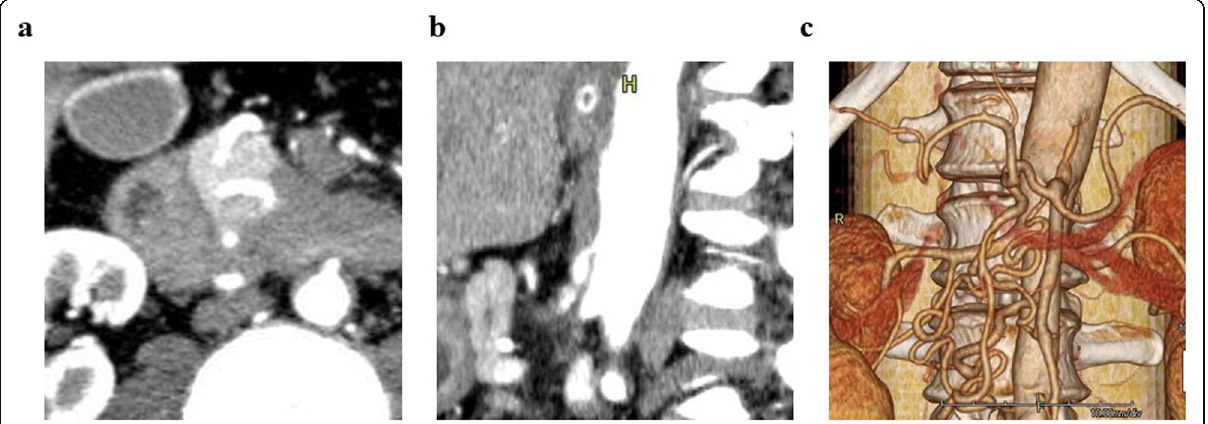
Fig. 1 Preoperative enhanced CT (case 1). a Low-density area surrounding normal tissue of the pancreas and duodenum. b CACS due to MALS. Hooked appearance and minimal post-stenotic dilatation. c 3D reconstruction image of blood vessels. Inferior pancreaticoduodenal artery was dilated and